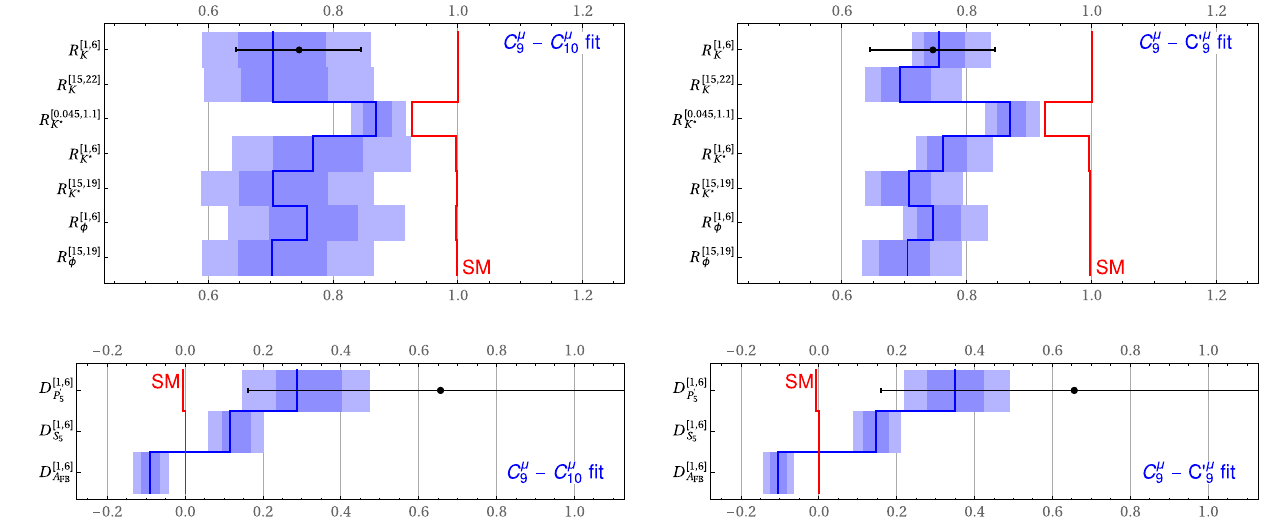
Fig. 4 Predictionsforleptonflavouruniversalityratiosanddifferences in new physics models with muon specific contributions to C 9 and C 10 , . The superscripts on the observables indicate the q 2 range or C 9 and C (cid:4) 9